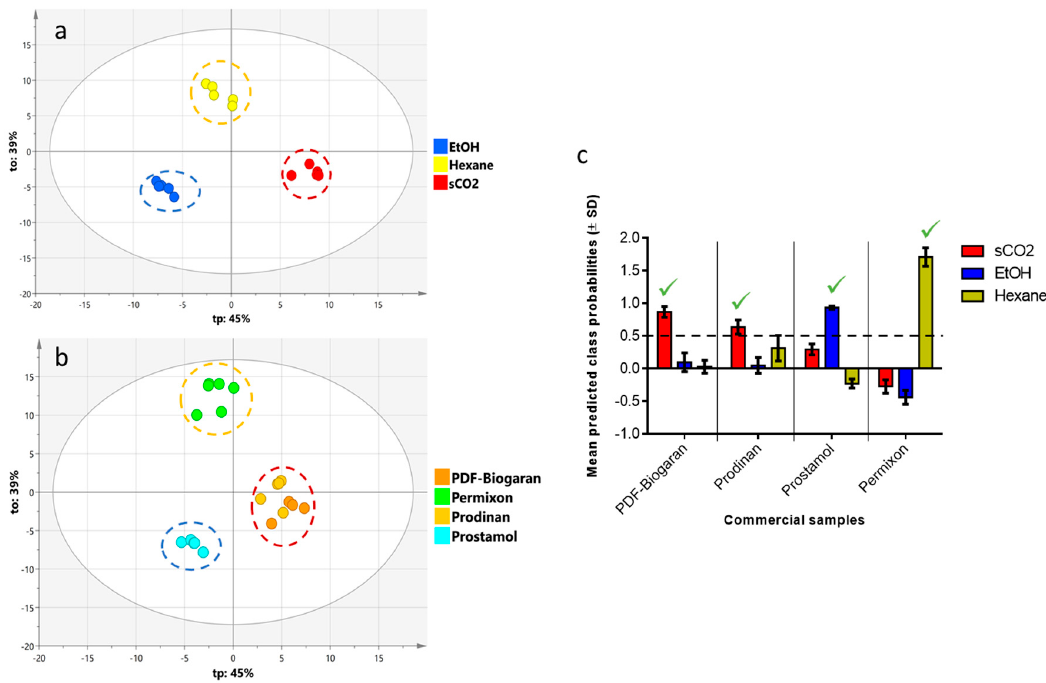
Figure 4. OPLS-DA model based on the solvent extraction process ( a ) the score plot using a laboratory extraction process as the Y class and selected features ranked by ANOVA in X. ( b ) the projection of commercial samples on the same score plot. ( c ) The bar plot of the predicted class probabilities of each commercial sample in their respective extraction process. A value above 0.5 indicates a high level of confidence in the predicted class. Laboratory samples: sCO 2 , supercritical carbon dioxide; EtOH: ethanolic; Hexane: hexanic. Commercial samples: PDF-Biogaran ® and Prodinan ® (sCO 2 ), Prostamol ® (EtOH), Permixon ®